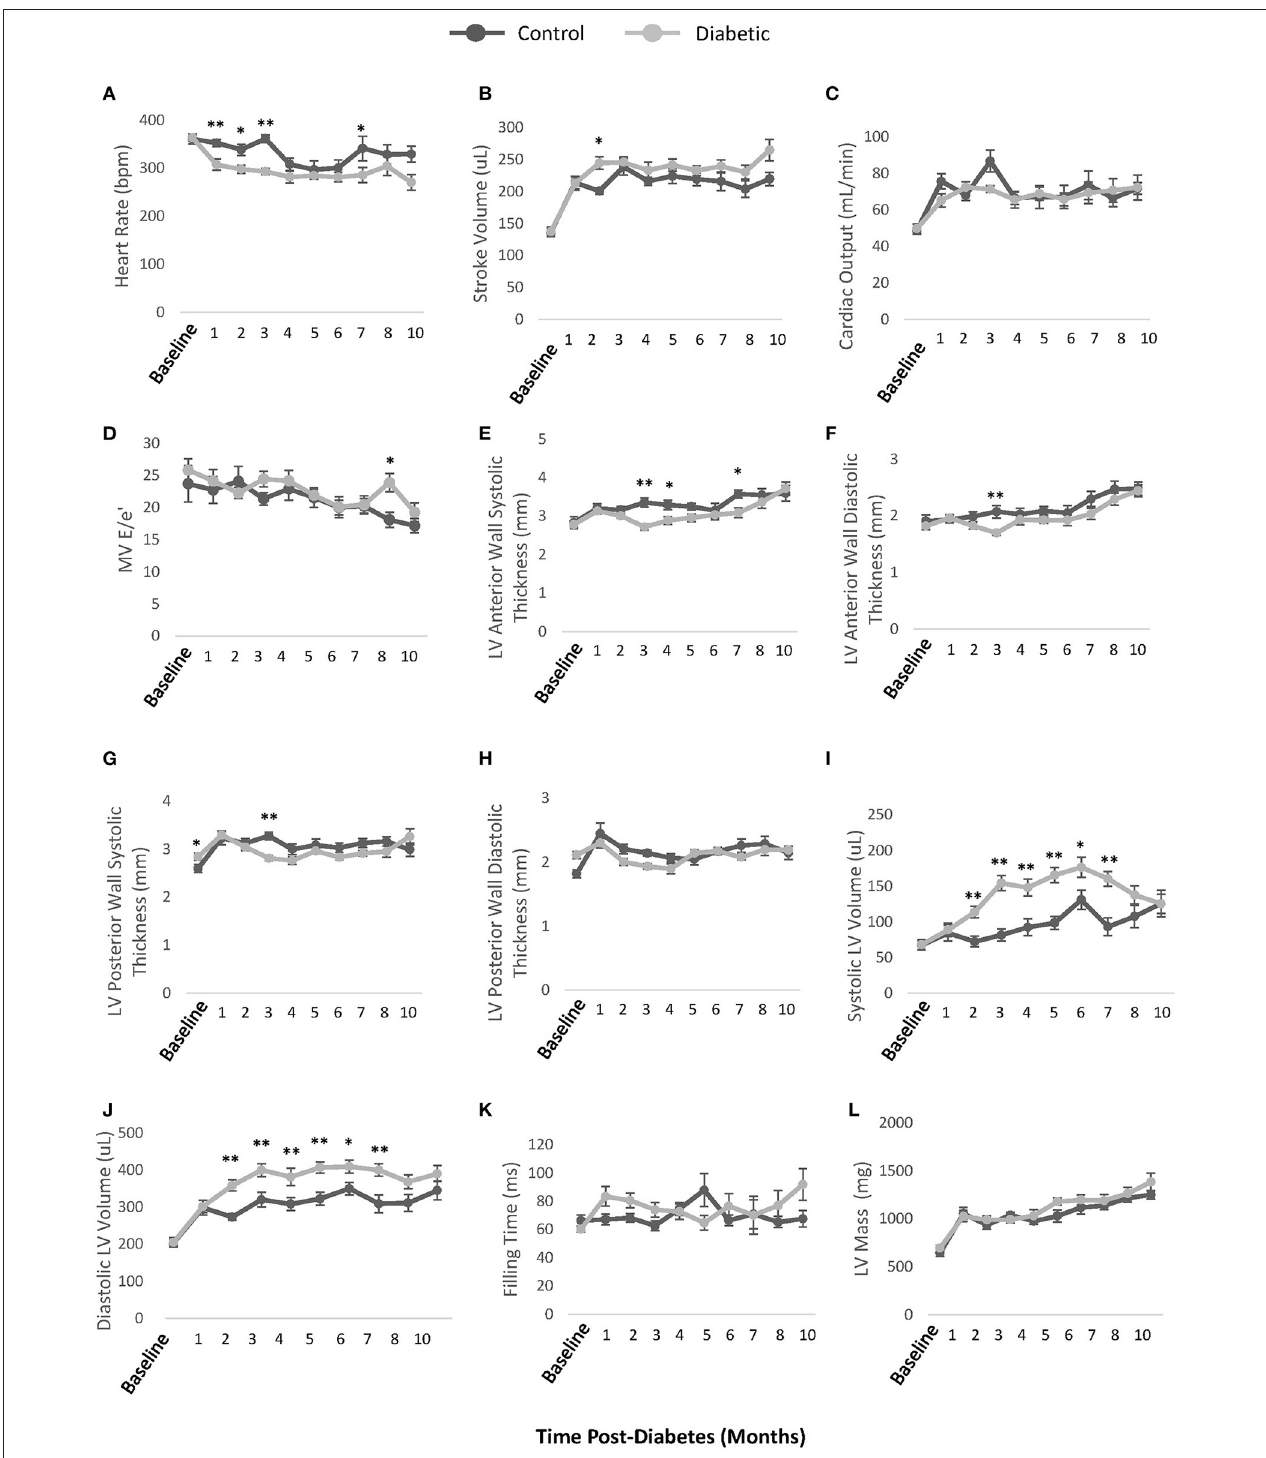
FIGURE 6 | Additional echocardiographic parameters. (A) Unconscious heart rate [beats per minute (bpm)]. (B) LV stroke volume calculated as EDV-ESV. (C) LV cardiac output calculated as heart rate × stroke volume. (D) Mitral valve E/e’ ratio representing atrial filling pressure, defined as the ratio between peak blood velocity in the LV and peak mitral annular velocity during early diastole. (E) LV anterior wall thickness at end-systole. (F) LV anterior wall thickness at end-diastole (G) LV posterior wall thickness at end-systole. (H) LV posterior wall thickness at end-diastole. (I) LV volume at end-systole. (J) LV volume at end-diastole. (K) LV Filling time. (L) LV mass. EDV, end-diastolic volume; ESV, end-systolic volume. Significance at individual timepoints is indicated (* p < 0.05), (** p < 0.01). Data represented as mean ± SEM.